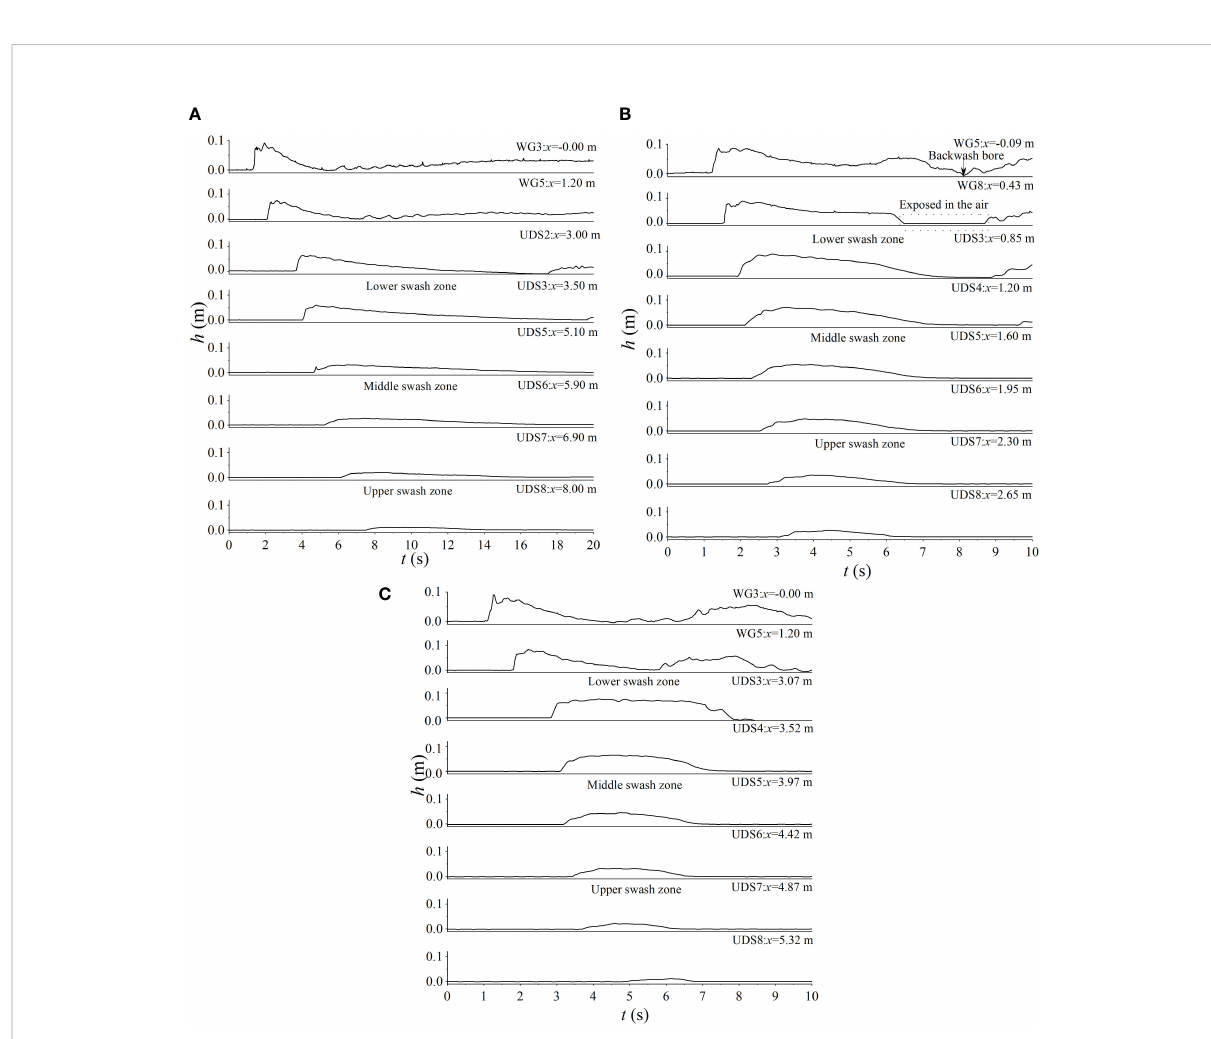
FIGURE 6 Time series of the measured water depth (h) at eight sampling locations (WG or USD) and comparison of swash depths in different cross-shore sections of the swash zone: (A) mild beach; (B) steep beach; (C) composite